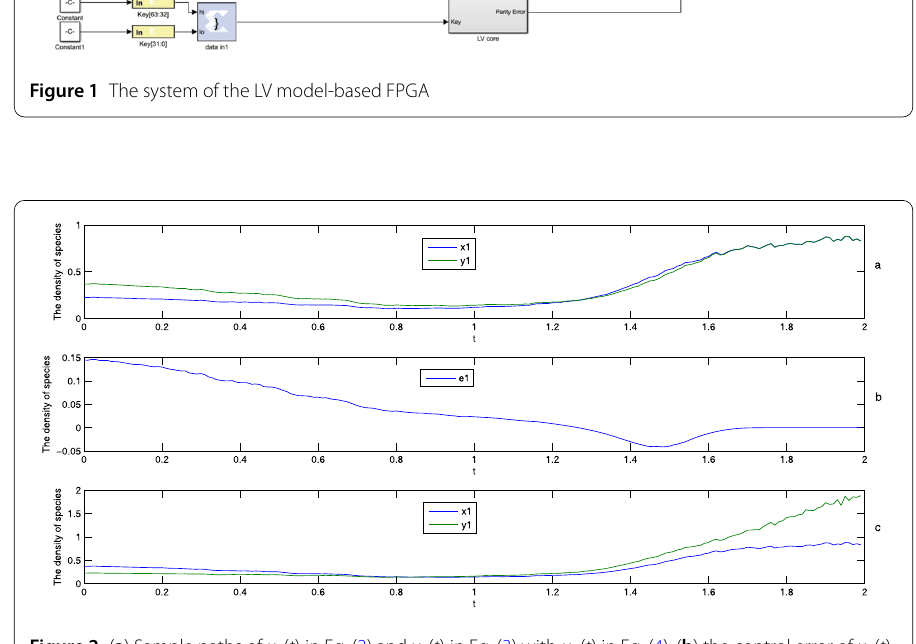
Figure 2 ( a ) Sample paths of x 1 ( t ) in Eq. (2) and y 1 ( t ) in Eq. (3) with u 1 ( t ) in Eq. (4); ( b ) the control error of x 1 ( t ) and y 1 ( t ); ( c ) Sample paths of x 1 ( t ) in Eq. (2) and y 1 ( t ) in Eq. (3) with u 1 ( t ) =